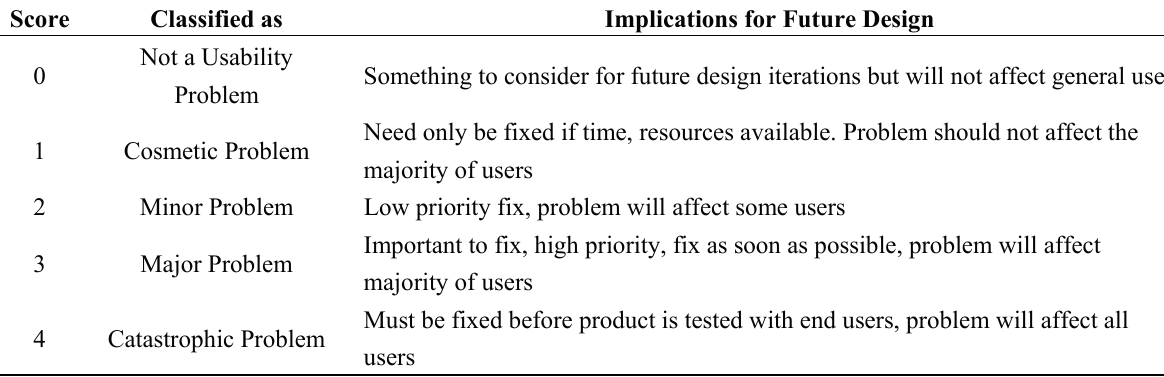
Table 2. Severity Scores.